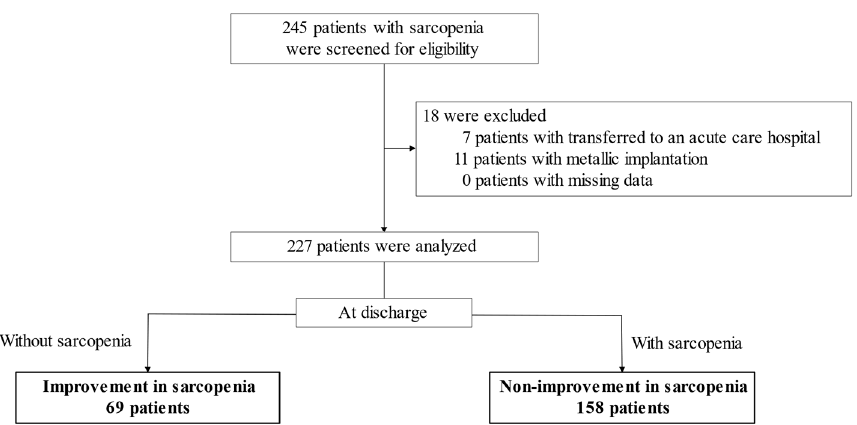
Figure 1. Flowchart of the studied participants.